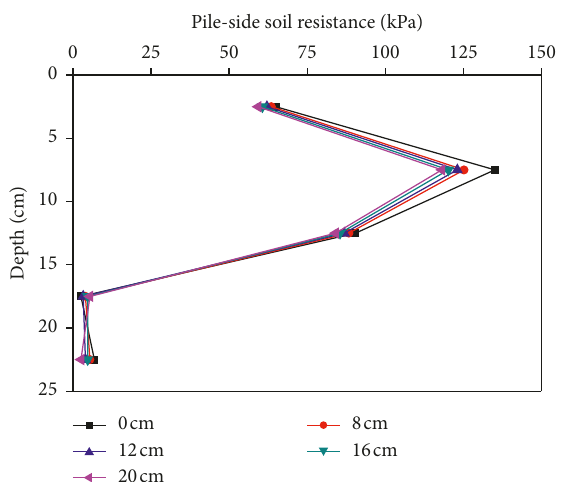
Figure 10: Change rule of the pile-side soil resistance with L